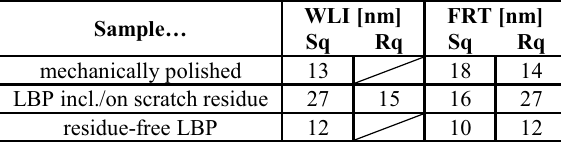
Table 1. Surface parameters before and after laser